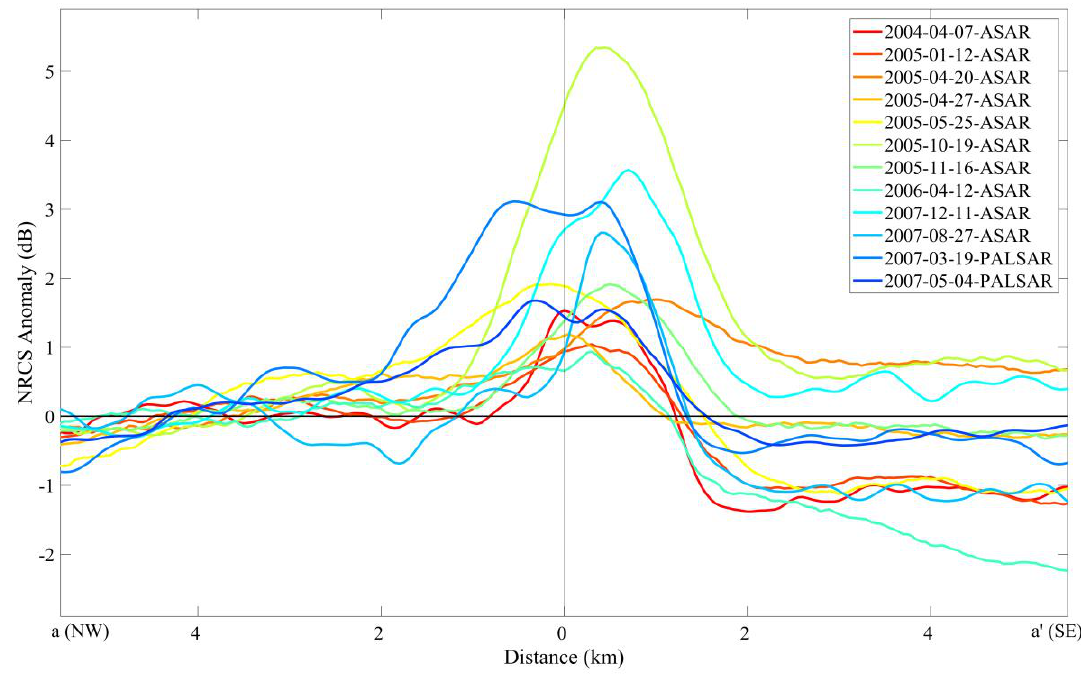
Figure 8. Variations in NRCS anomaly values (dB) along the section, a-a’, in Figure 3b.